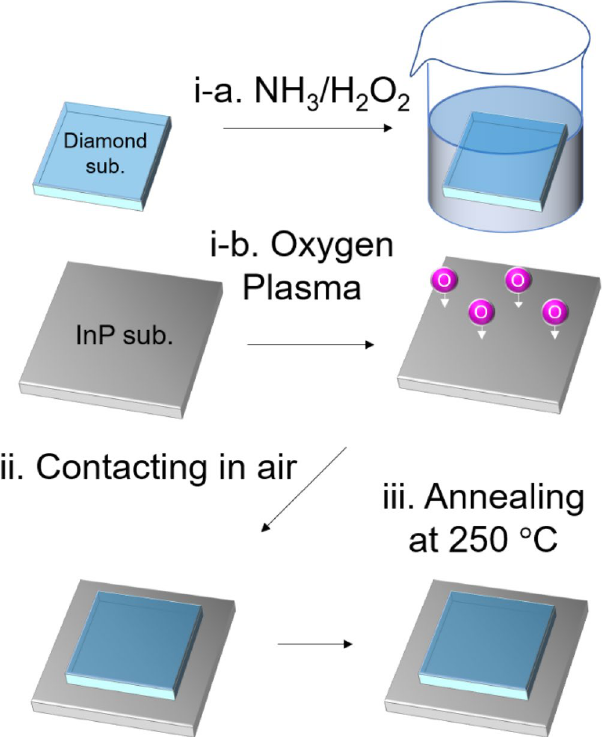
Figure 1. Experimental procedure to directly bond the InP and diamond substrates at low temperatures under atmospheric conditions.